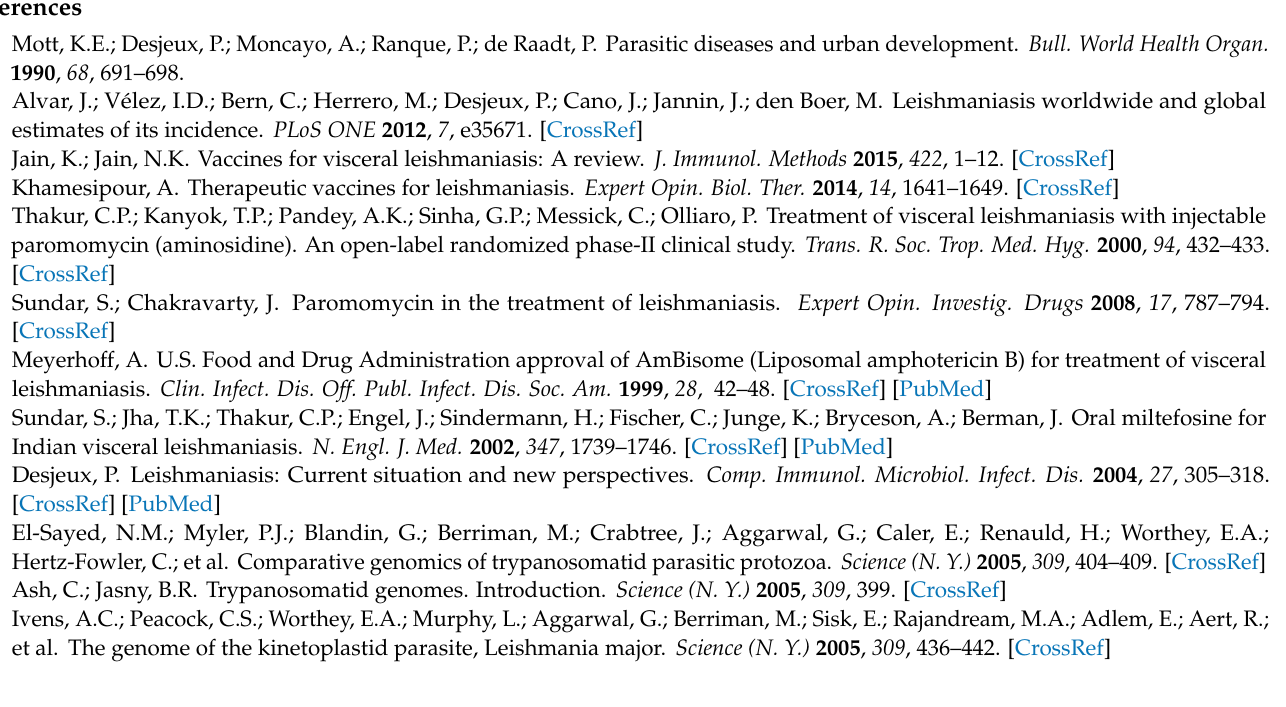
Leishmania braziliensis and Leishmania infantum . Figure S2: Protein structure visualization for CRK in different Leishmania strains. Figure S3: Superposition of the reported catalytic site and the predicted pocket for CDK and AKT homologues in Leishmania braziliensis . Table S1: List of all the proteins present in the human PI3K/AKT and apoptosis pathways with potential orthologues in different Leishmania species. Tables S2–S8: Summary of the modelling variables and the druggability score for the kinases detected in the five species of Leishmania analysed. Table S9: List of best 20 compounds per kinase model based on the AutoDock Vina score. Table S10: Full list of compounds IDs and SMILES representations of their chemical